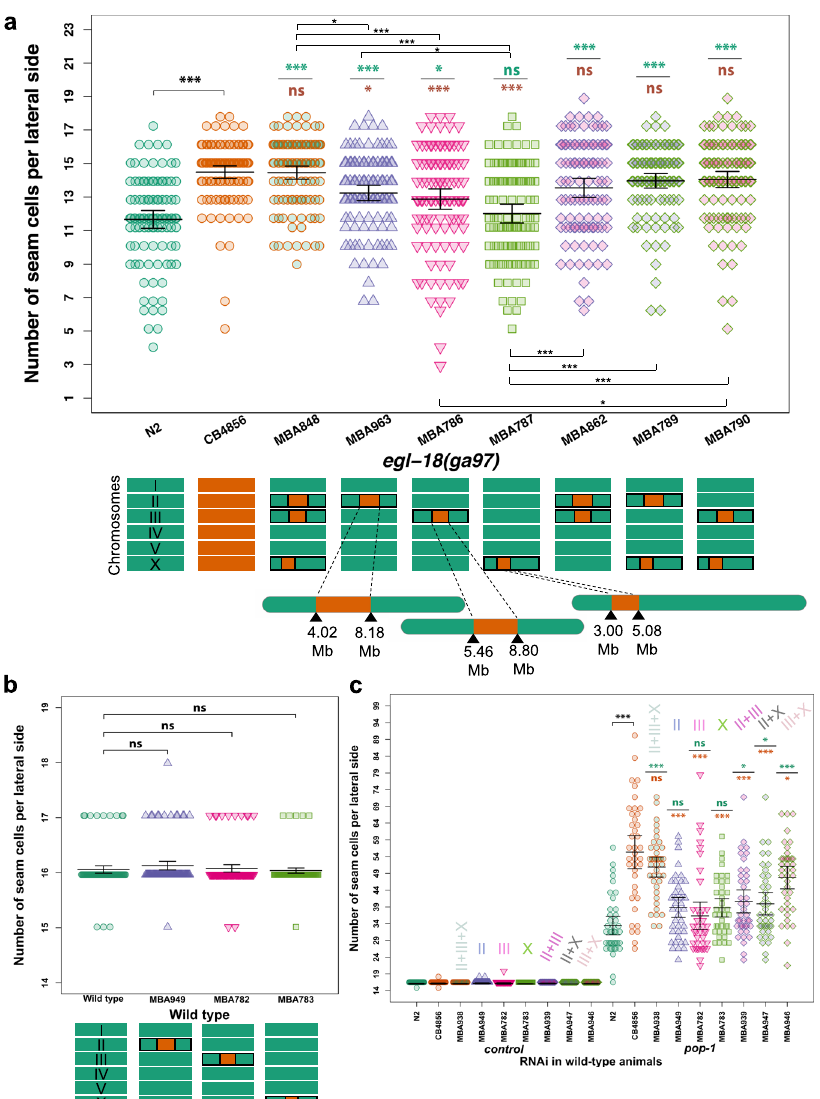
Fig. 4 Phenotypic analysis of near isogenic lines identi fi es major QTLs. a Seam cell number in near isogenic lines containing individual and combinations of the identi fi ed QTLs from CB4856 into the egl-18(ga97) N2 background. One-way ANOVA showed that SCN was signi fi cantly affected by the strain ( F (8, 905) = 16.55, p < 2.2 × 10 − 16 , n ≥ 100 independent animals). Stars show signi fi cant differences by post hoc Tukey HSD (*** p < 0.001 or * p < 0.05). Note that QTLs on chromosomes II and III, but not on the X, were suf fi cient to increase seam cell number in the egl-18(ga97) mutant in the N2 background. Cartoon of chromosomes below the graph depict the genotype of the strain. b SCN counts in near isogenic lines containing individual QTLs in a wild-type background. One-way ANOVA shows no statistically signi fi cant differences in SCN of NILs compared with wild-type with no QTLs ( F (3, 396) = 1.34, p = 0.26, n = 100 independent animals). c pop-1 RNAi in near isogenic lines in a wild-type background containing individual and combinations of the identi fi ed QTLs. The same colour code is used as in a to de fi ne different combinations of QTLs. A signi fi cant effect of strain was found on SCN upon pop-1 RNAi using one-way ANOVA ( F (8, 351) = 17.85, p < 2.2 × 10 − 16 , n = 40 independent animals). Error bars in a – c indicate 95% con fi dence intervals around the mean. Comparisons against N2 and CB4856 are shown with green and orange stars, respectively, in a and c and represent p values by one-way ANOVA followed by post hoc Dunnett ’ s multiple comparison test (*** p < 0.001 or * p < 0.05). Source data are provided as a Source Data fi